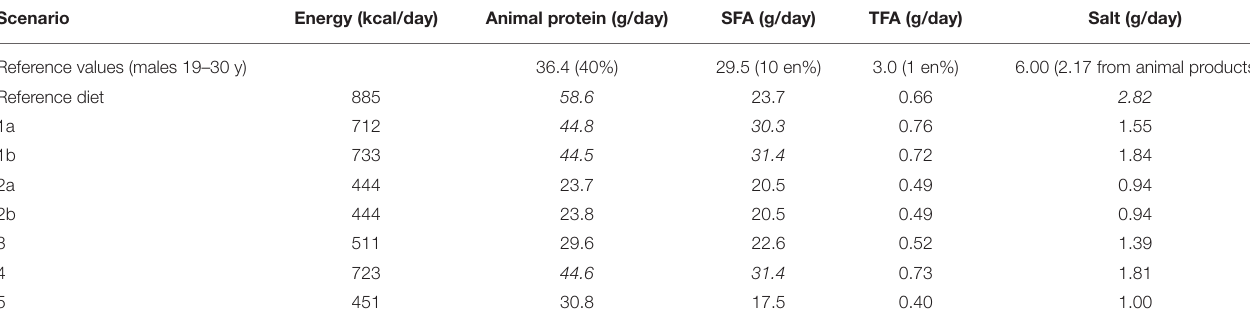
TABLE 4 | Nutritional intake per day by consumption of animal (-derived) products of differing scenarios and of reference ( = current) diet.